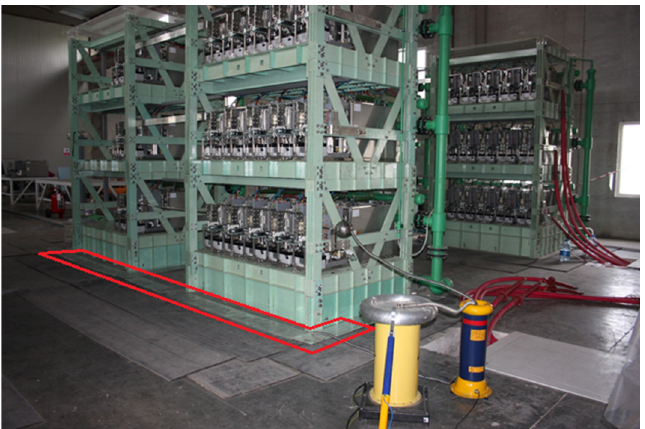
Figure 20. Grounding grid with metallic plates.